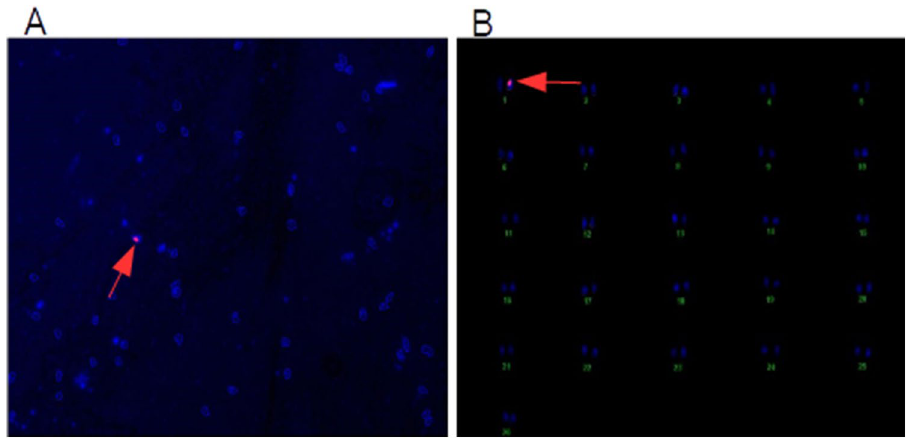
Figure 10. ( A ) Agl42 probe hybridization; ( B ) Karyotyping and AGL42 location on chromosome 1 in cotton genome specified by fluorescent